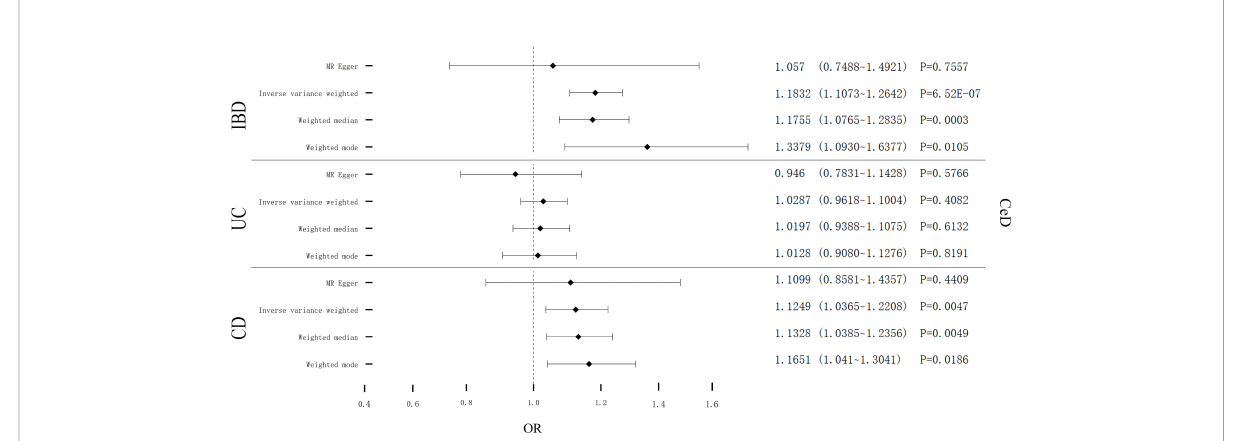
FIGURE 3 Causal estimates given as odds ratios (ORs) and 95% con fi dence intervals for the effect of IBD, UC, and CD on CeD. IBD, In fl ammatory Bowel Disease; UC, Ulcerative Colitis; CD, Crohn ’ s Disease; CeD, Celiac